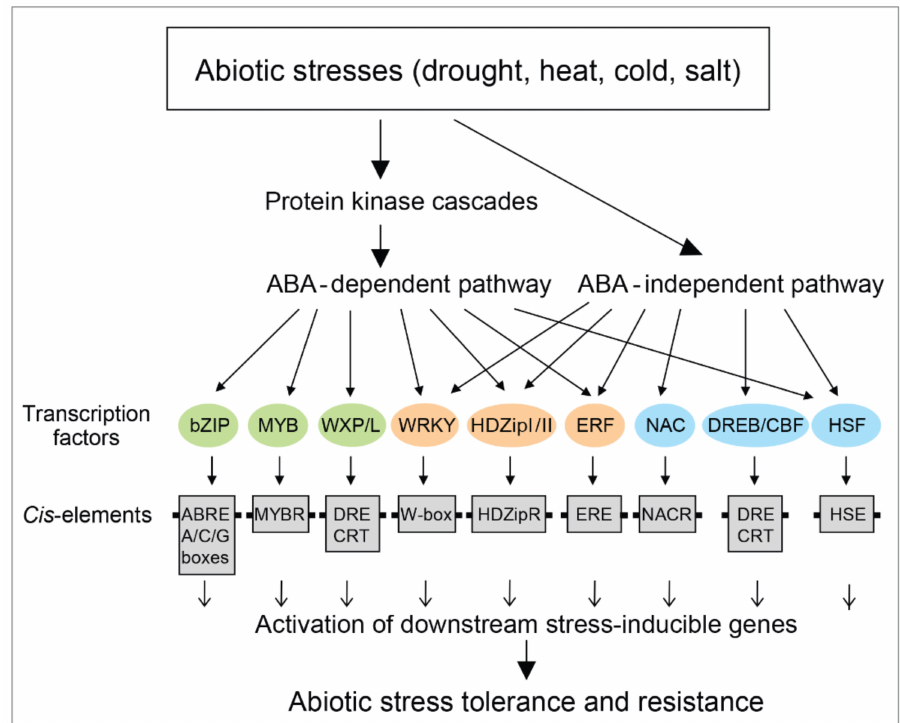
Figure 3. Biotic and biotic stresses are perceived by plants through ABA-dependent and ABA- independent pathways or between cross-talks of these pathways (based on [26,27,84]). Color coding differentiates between TFs that are controlled by ABA-dependent (green), ABA-independent (cyan) and ABA-dependent/independent (orange)